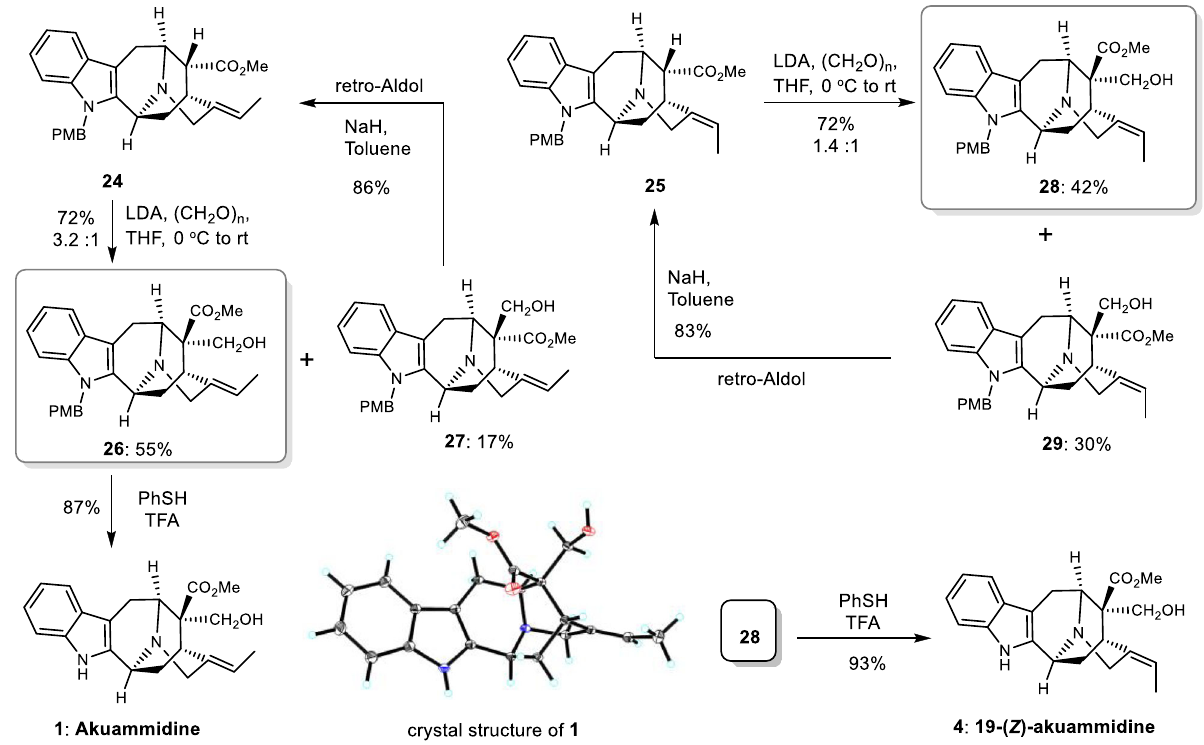
Fig. 5 Synthesis of akuammidine (1) and 19- Z -akuammidine (4). Aldol condensation with formaldehyde. LDA lithium